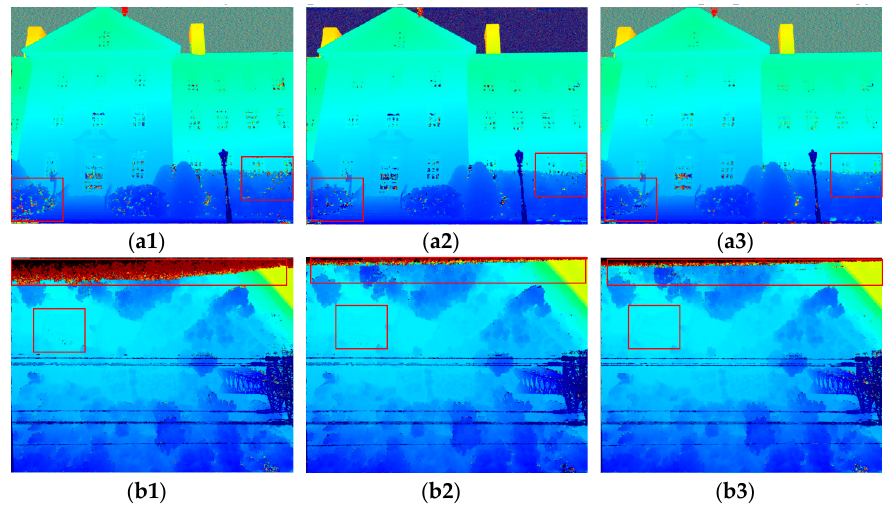
Figure 4. Comparison of the depth maps with three different view selection and propagation strategies. ( a1 , b1 ) are the results of the “top-k-winners-take-all” strategy with symmetric red-black propagation; ( a2 , b2 ) are the results of Colmap with sequence propagation; ( a3 , b3 ) are the results of the proposed strategy with random red-black propagation.